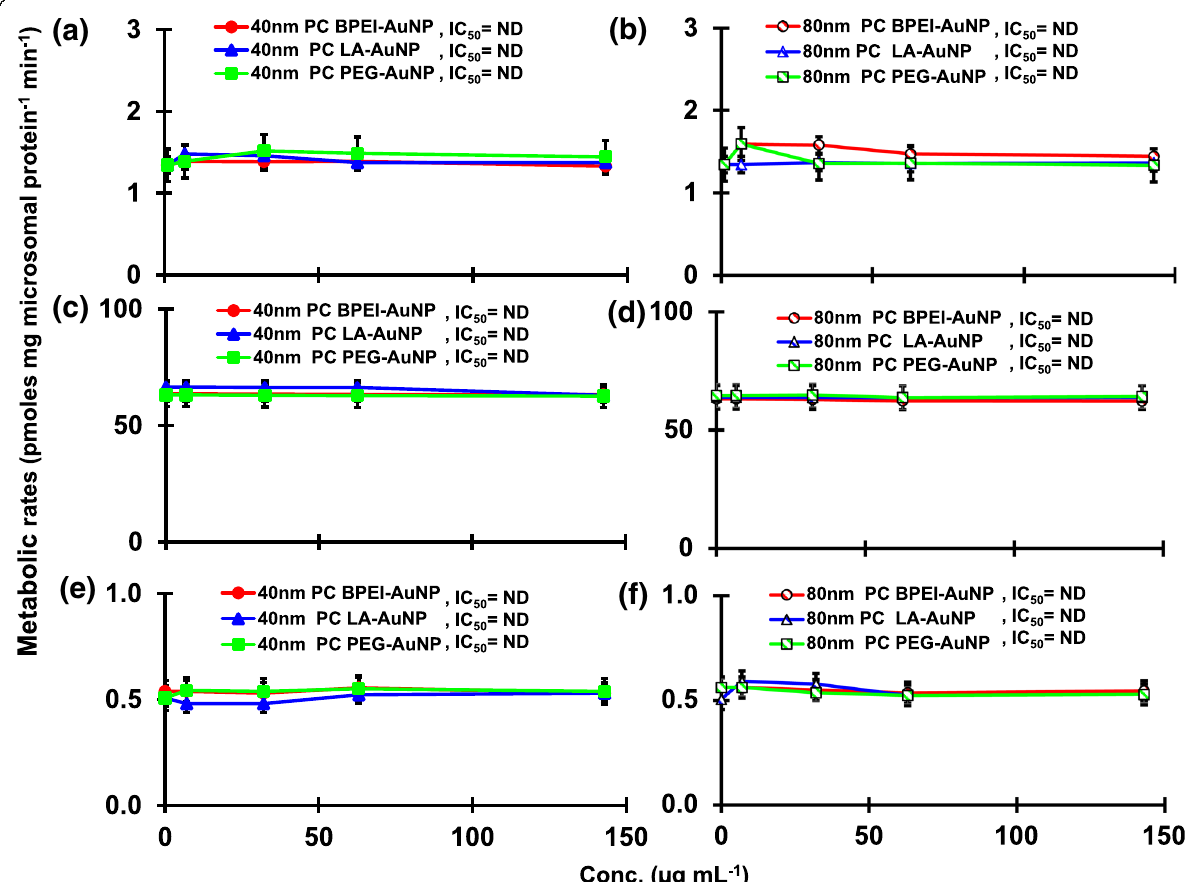
Fig. 5 Effects of PC AuNP on the production of 2 β -OH TST ( a , b ), 6 β -OH TST ( c , d ) and 15 β -OH TST ( e , f ) in pHLM. Data represent mean ± S.D. ( n =3). IC 50 , half maximal inhibitory conc.; pHLM , pooled human liver microsomes; ND , not determined by fitting a Hill equation with variable slope to the observed data using GraphPad Prism®; PC , human plasma protein corona; BPEI , branched polyethylenimine; LA , lipoic acid; PEG , polyethylene glycol; Conc, concentration; 2 β -OH TST, 2 β -hydroxytestosterone; 6 β -OH TST, 6 β -hydroxytestosterone; 15 β -OH TST, 15 β -